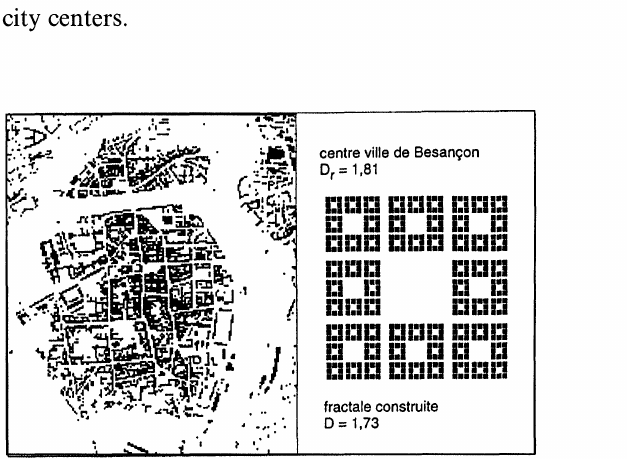
FIGURE 7 The city center of Besancon (D 1.81) and a qualitative fractal transcription of the pattern (D 1.73). The distribution of the lacunas have been chosen in such a way that some characteristic shapes of the pattern appear, in partic- ular the street system and the rather great courtyards in the center of the blocks of